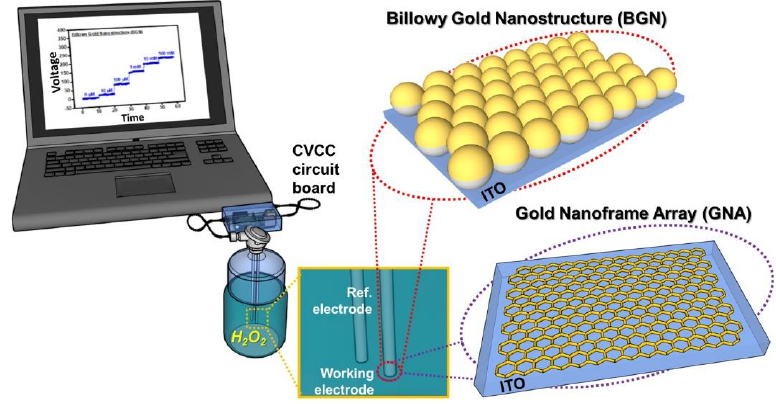
Figure 1. Schematic diagram of the real-time H 2 O 2 sensing setup using a billowy gold nanostruc- ture (BGN) and gold nanoframe array (GNA) extended-gate field-effect transistor (EGFET) integrated with a portable constant voltage–constant current (CVCC) circuit system.